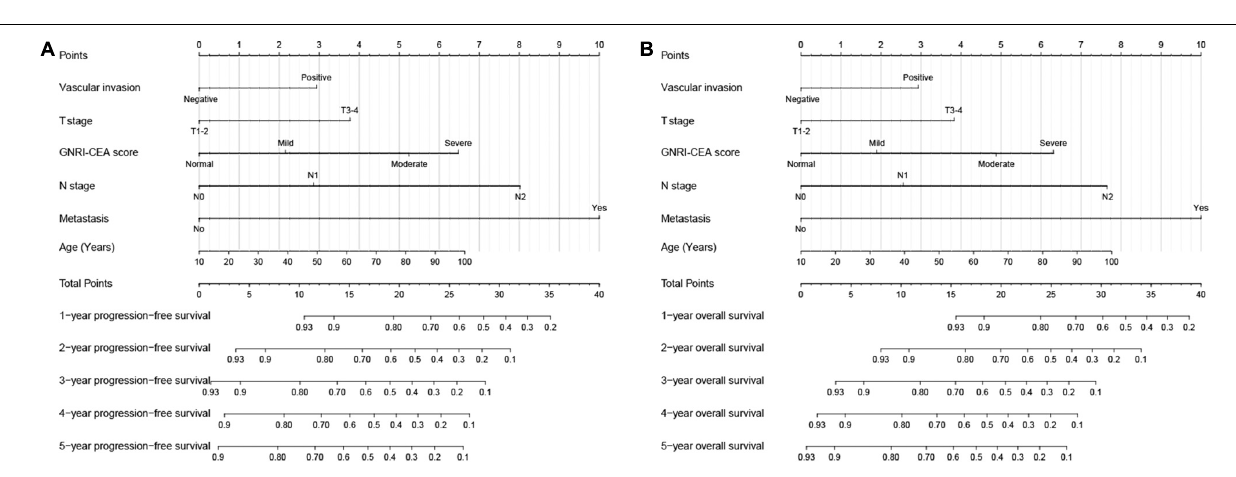
nomograms were superior to TNM staging in predicting the prognosis of CRC patients ( Supplementary Figures 11C,D ). The present nomogram also achieved good predictive accuracy ( Supplementary Figure 12A ) and prognostic discrimination ( Supplementary Figure 12B ) in the internal validation